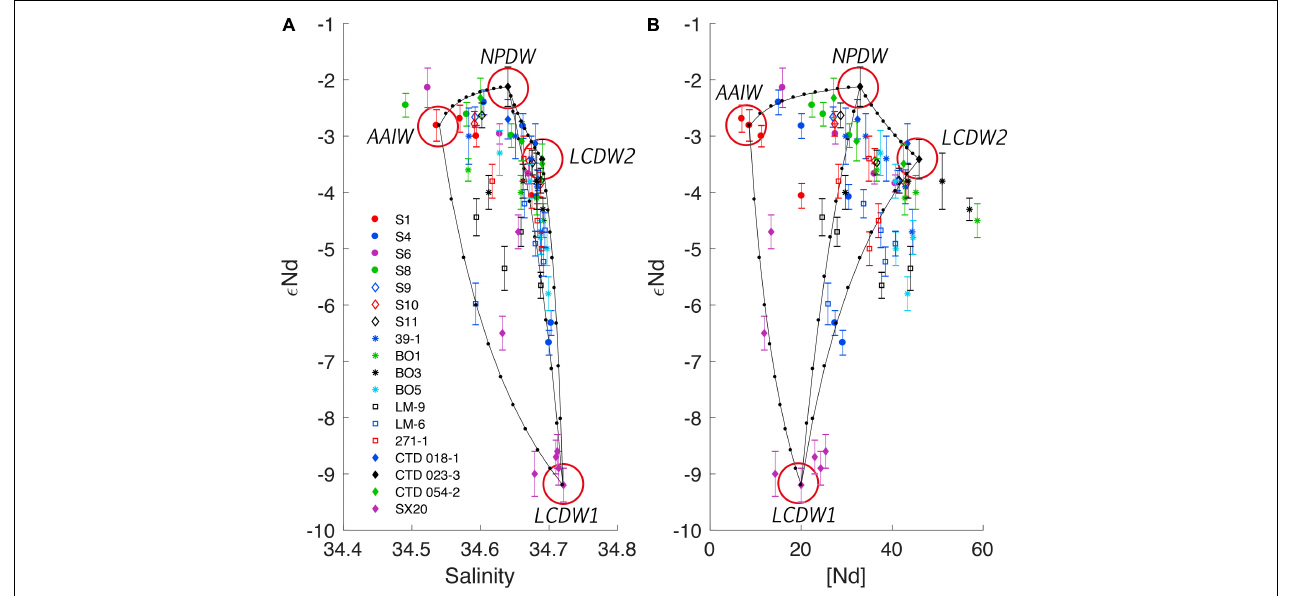
FIGURE 7 | Mixing relationships of major deep-water masses in the northern Pacific based on Nd isotope compositions, salinity (A) and [Nd] (B) . LCDW1 represents pristine LCDW1 from the South Pacific (Amakawa et al., 2013), LCDW2 represents LCDW as found in the Bay of Alaska (Haley et al., 2014). The NPDW end-member was chosen just after its transformation from LCDW in the Bay of Alaska, and AAIW represents pre-modified AAIW found at station S1. Calculated mixing lines between the four end-members with ( Table 3 ) 10% increments (black dots) are displayed. As discussed in the text, these mixing relationships cannot be considered quantitative due to the effects of non-conservative inputs along the flow path of the deep-water